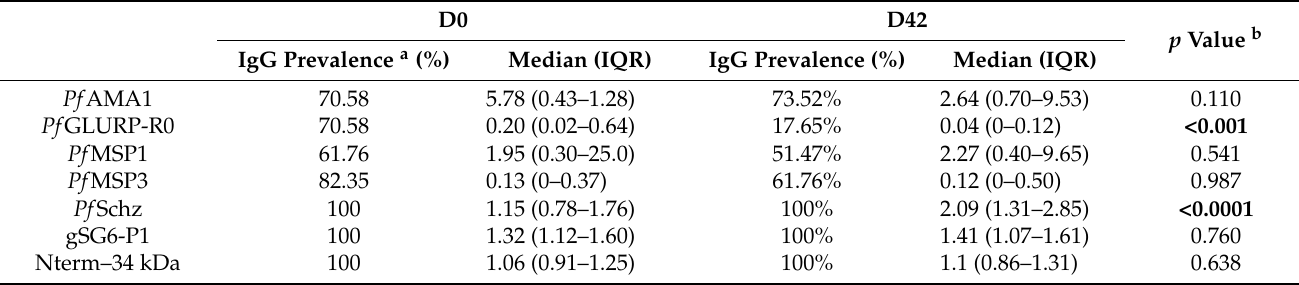
Table 1. IgG seroprevalence and level of IgG response to Plasmodium falciparum antigens and to gSG6-P1 and Nterm–34 kDa salivary peptides on D0 and